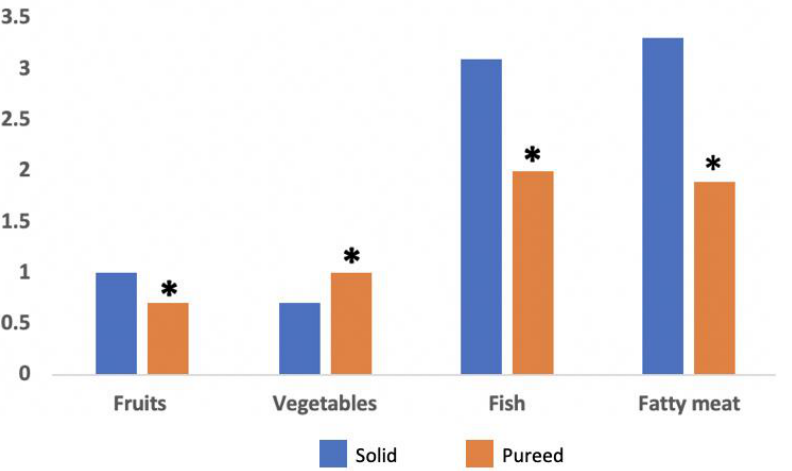
Figure 4. The average consumption of solids and pureed foods in Spanish preschool children with autism spectrum disorders for selected food groups (vegetables and fruit are expressed in serv- ings/day, and fish and meat in servings/week). * P < 0.05.